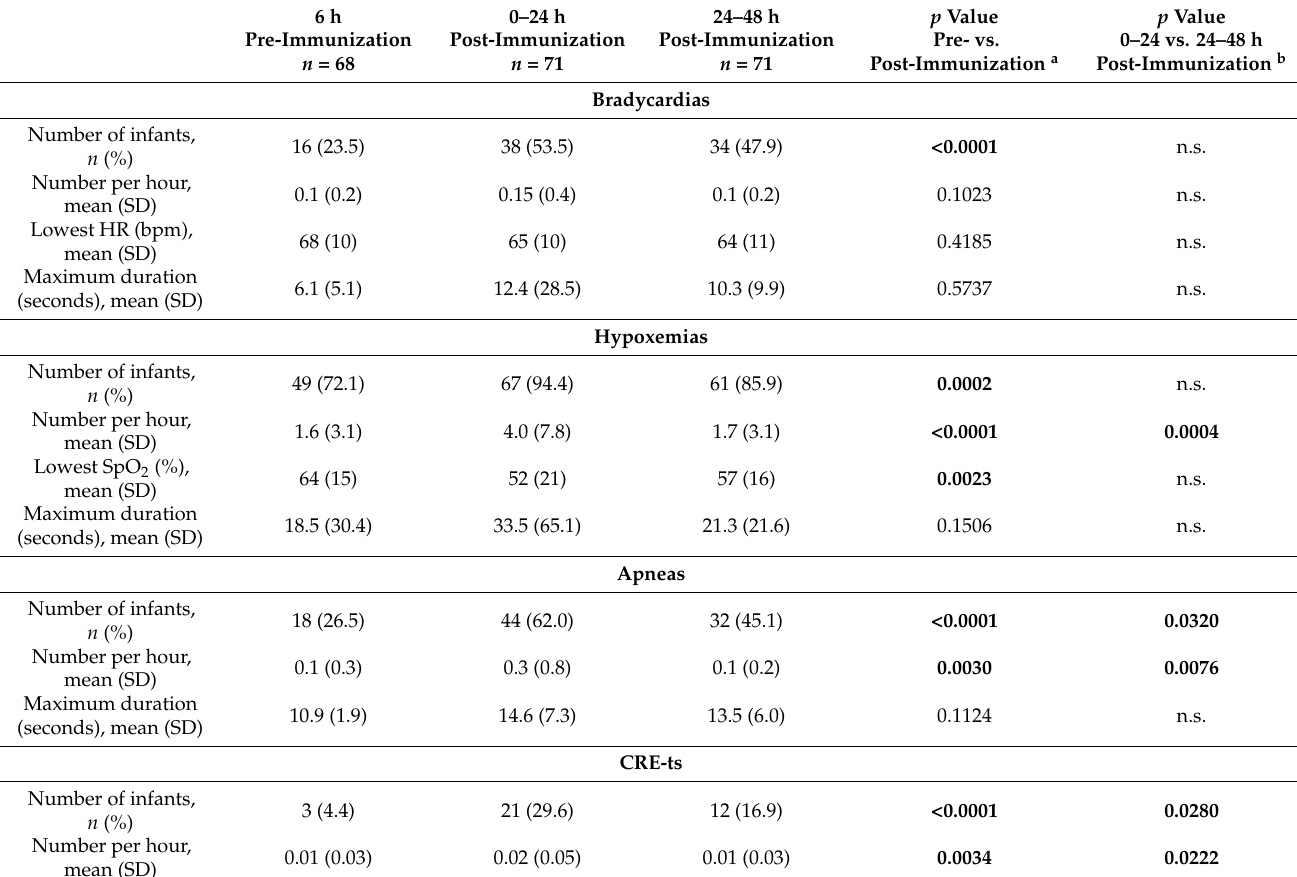
Table 2. Results on bradycardias, hypoxemias, apneas and CRE-ts for all included infants.